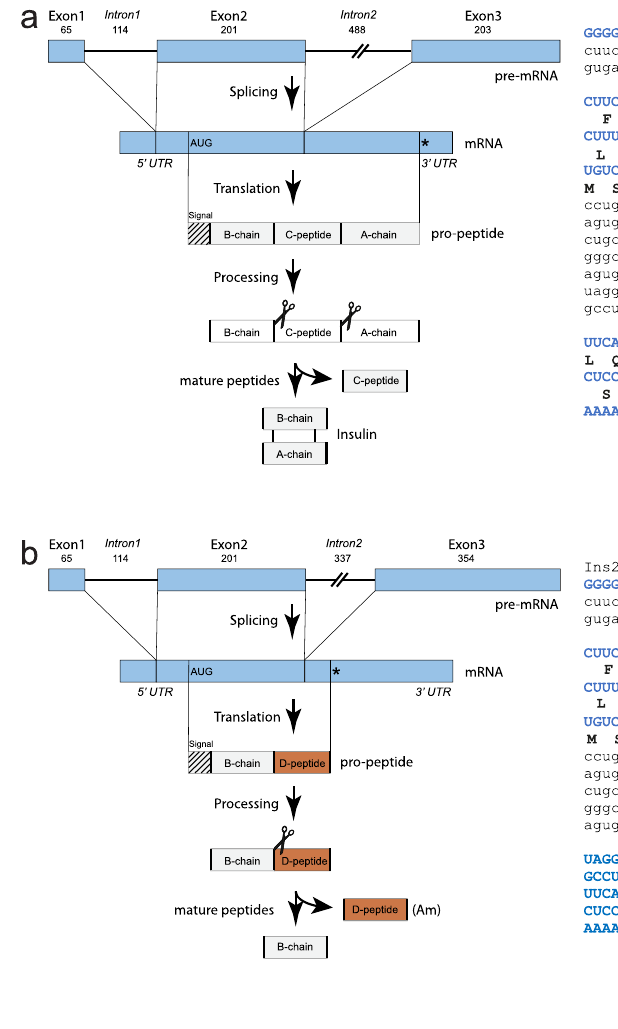
b The Ins2-202 transcript (Ensembl ID: ENSMUST00000105930.8) match the Uni- prot entry D3Z596, and is a 79 amino acid variant of insulin. Alternative splicing betweentheD1donorsiteandthecrypticA2acceptorsiteintroducesanewreading frame with a premature stop-codon forming a pro-peptide consisting of an intact B-chain and a uncharacterized peptide (D-peptide) after prohormone convertase cleavage. The PAM enzyme converts the terminal Glycine in 2 sequential steps to a C-terminal amidation. Bottom right contains an alignment between the classic C-peptide and the